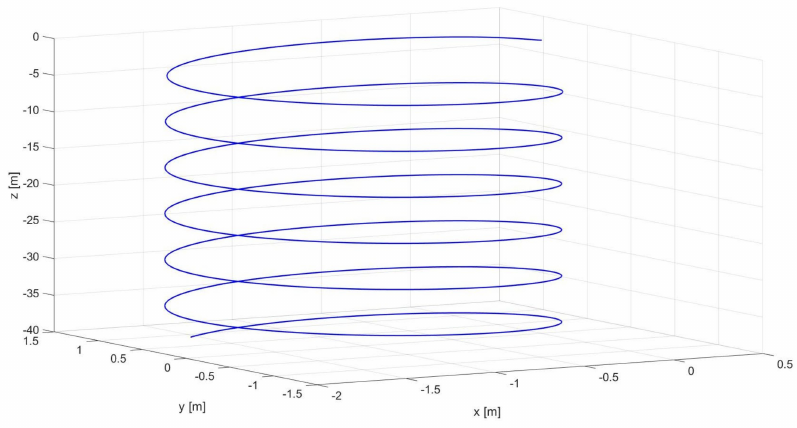
Figure 10. 3D view of trajectory 1: position trajectory of the controlled quadrotor system.